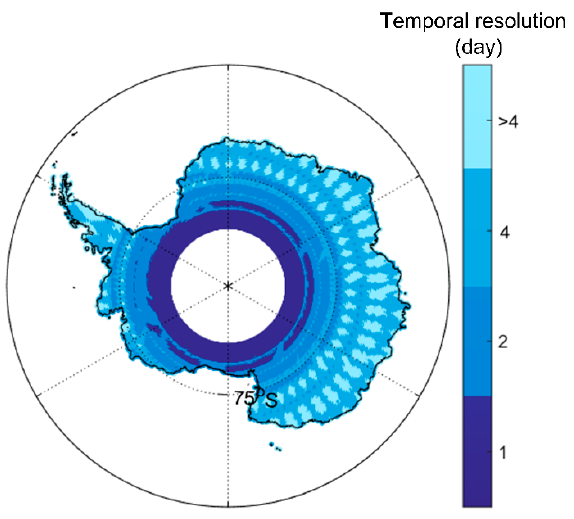
Figure 1. Maximum temporal resolution of CloudSat snowfall over the Antarctic Ice Sheet (AIS).